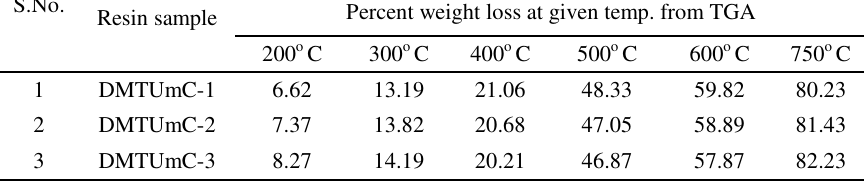
Table 4 . TGA of unreinforced DMTUmC : HMTA cured materials